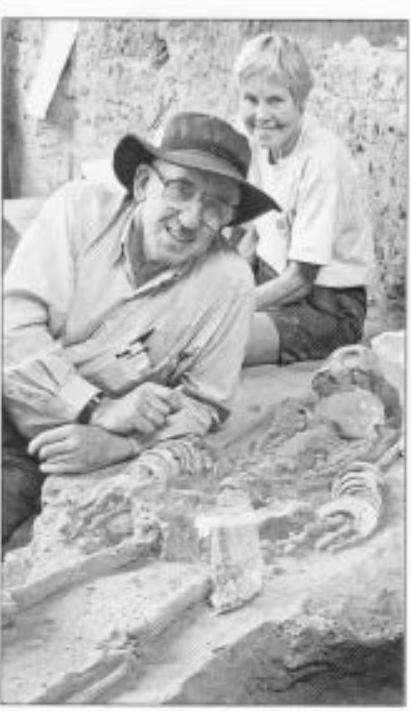
Figure 1 Charles High am at work on a rich Bronze Age burial at the site of Ban Non Wat, Thailand, February